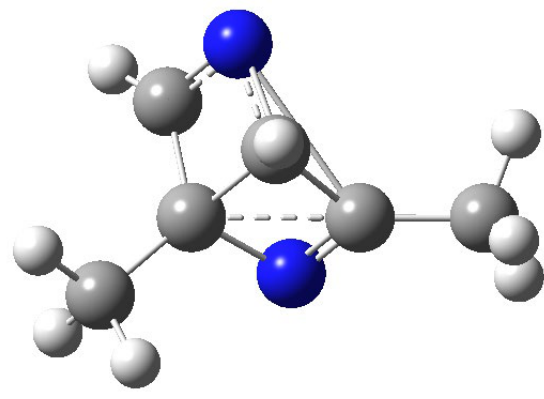
Figure 4. Transition state of the conversion of 5 into 2 .